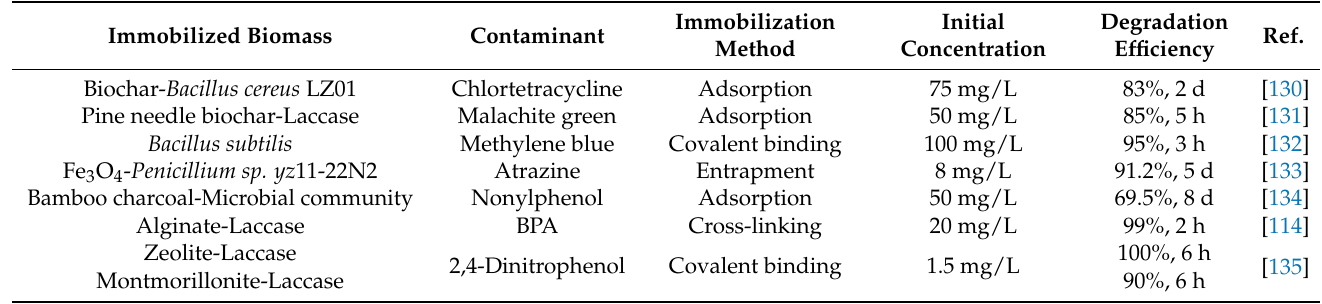
Table 4. Parameters of immobilized enzyme for Organic pollutant